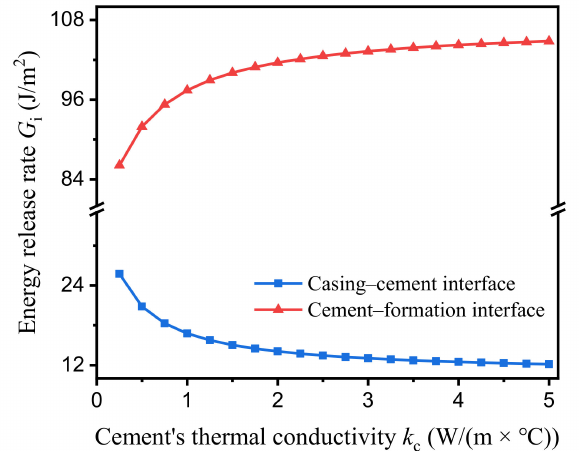
Figure 7. E ff ect of cement’s thermal conductivity on the interfacial